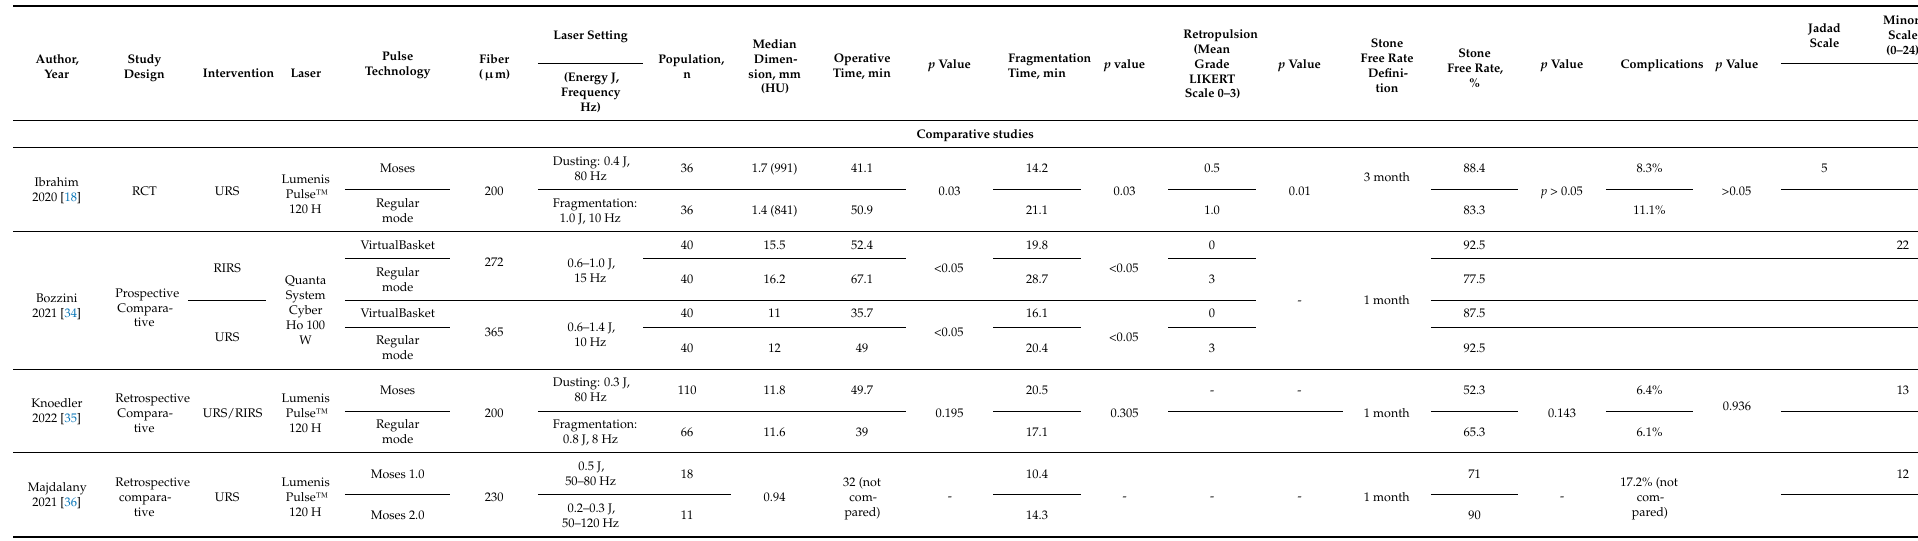
Table 2. Study details of the included in-vivo